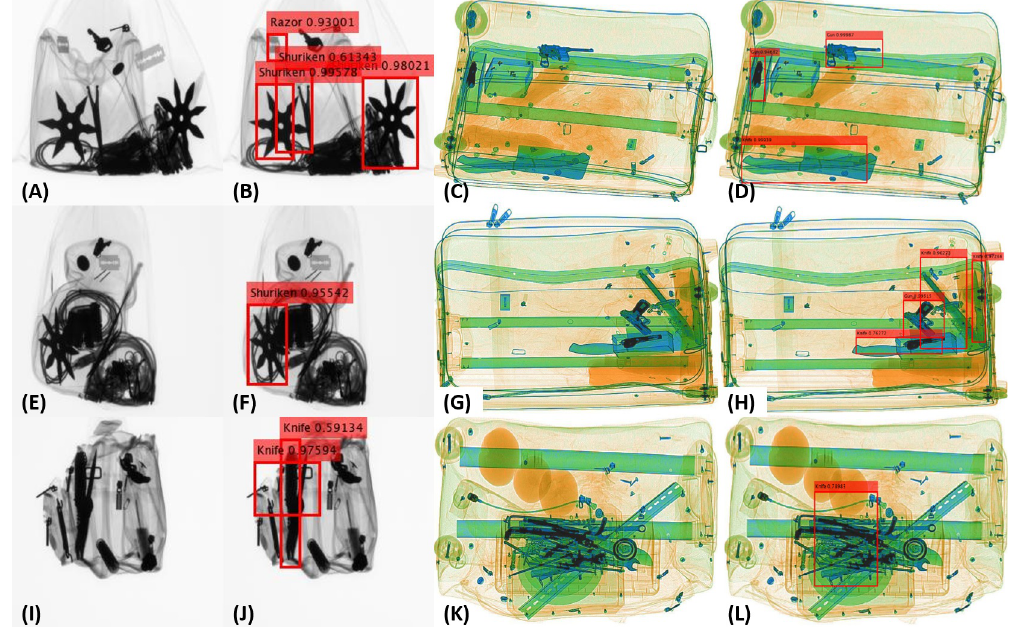
Figure 8. Failure cases on the GDXray [15] and SIXray [14] dataset are shown in ( A – L ). Moreover, the first and third column show the original